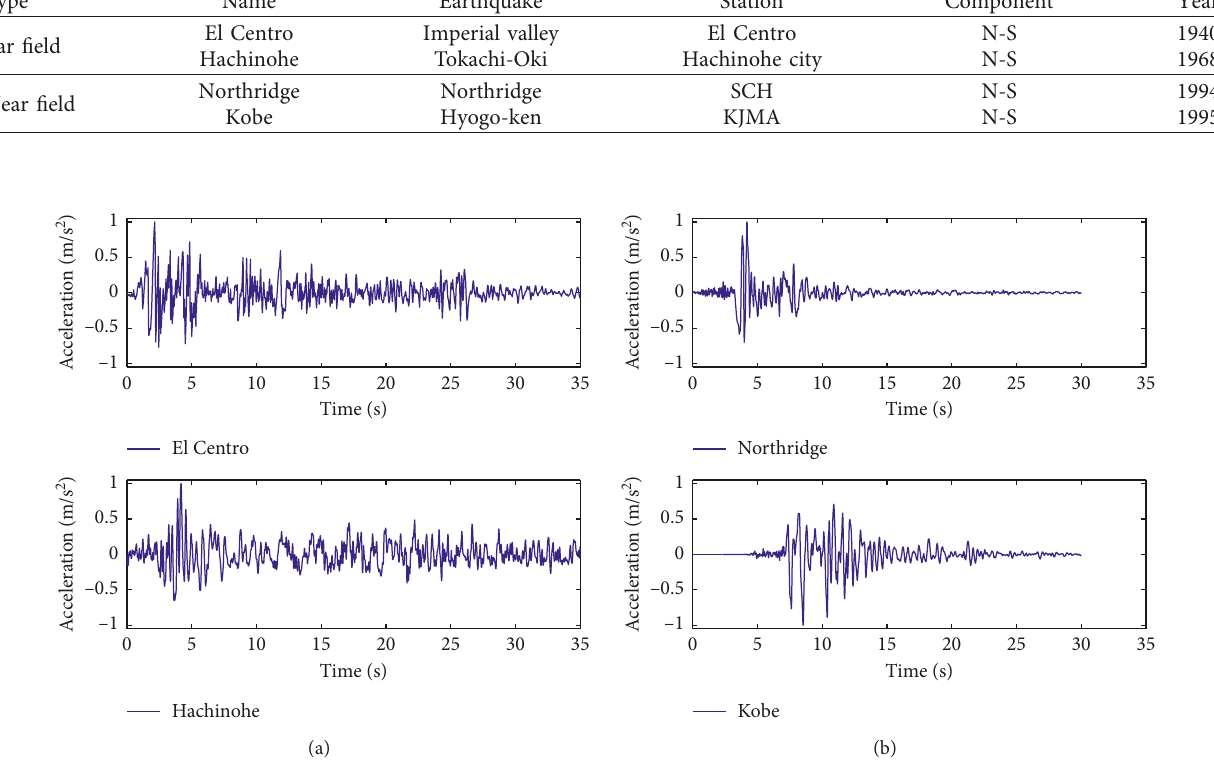
Figure 11: Time history curve of seismic records. (a) Far-field seismic waves. (b) Near-field seismic waves.